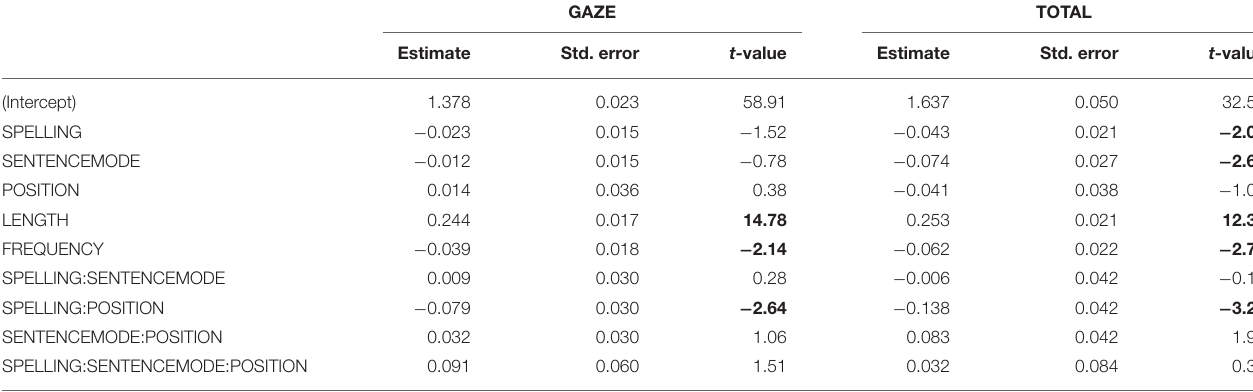
TABLE 3 | Gaze and Total, model data for the independent variables of the mean number of fixations. GAZE TOTAL Estimate Std. error t- value Estimate Std. error t-